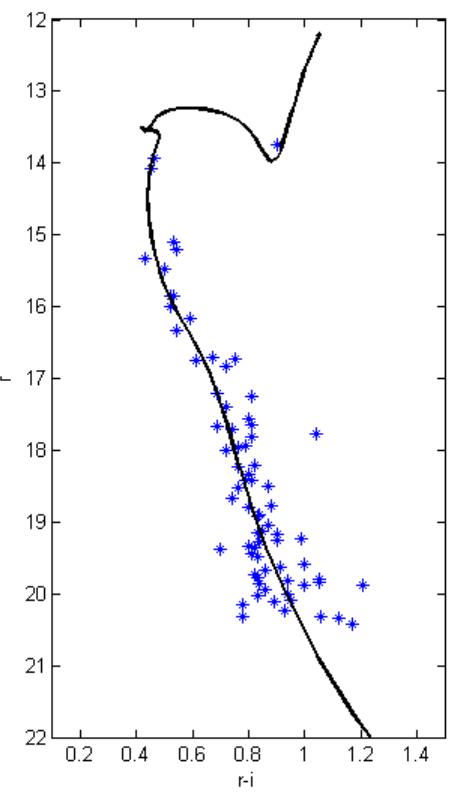
Fig. 2. The ( r , r − i ) CMD for stars within 1 . 5 (cid:48) of the center of NGC 1857. The solid line shows the isochrone for the age log t = 8 . 65.